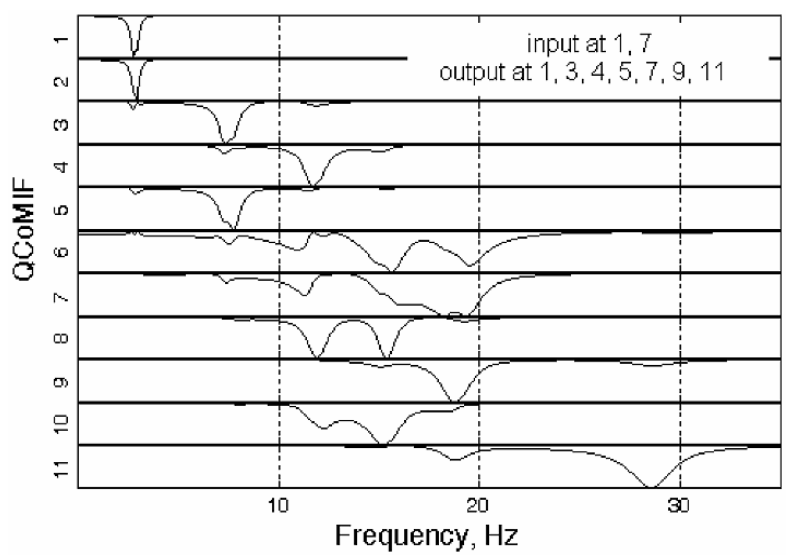
Fig. 18. QCoMIF for the 11-dof system.